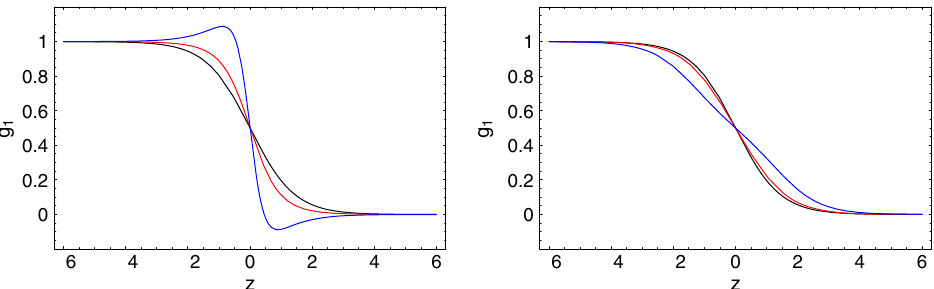
FIG. 3. Quadrupole gradient evaluated as a function of longitudinal position z along the axis of the magnet (black line), and away from the axis for two different values of the parameter b 2 (red and blue lines). In the left-hand plot, the off-axis gradient is shown for ffiffiffi p 2 x ¼ 1 = , y ¼ 0 ; in the right-hand plot, the off-axis gradient is shown for x ¼ 0 , y ¼ 1 = gradient for b 2 ¼ 2 , and the blue line shows the gradient for b 2 ¼ 4 . The gradient along the axis of the magnet is independent of the value of b 2